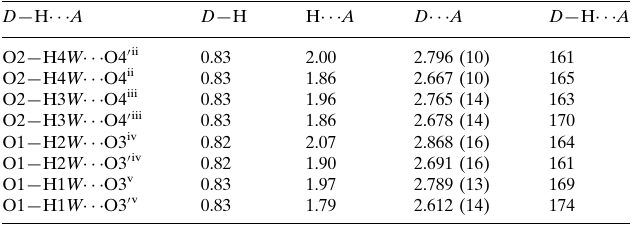
Hydrogen-bond geometry (A˚ , (cid:3) ). D —H (cid:2)(cid:2)(cid:2)